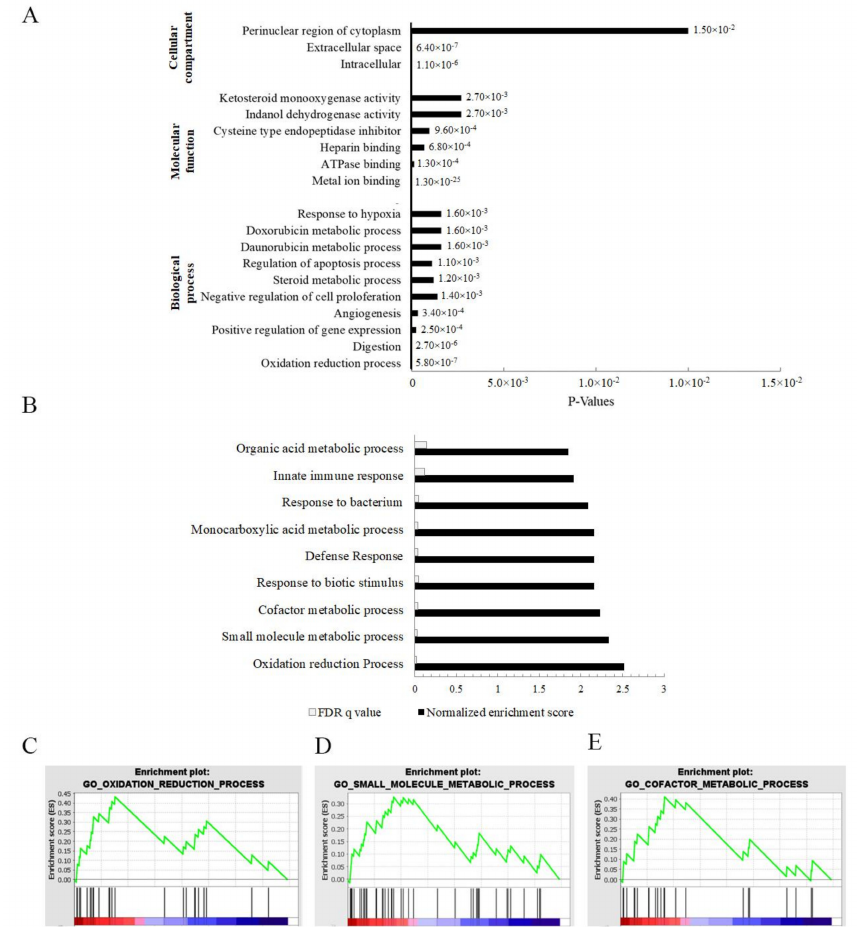
Figure 3. Identification of cisplatin-resistance-related genes in signet ring gastric cancer by bioinfor- matics analysis of RNA sequencing data: ( A ) David Bioinformatics functional annotation according to gene ontology (GO) in biological process, molecular function, and cellular compartment; ( B ) top 10 GO terms of Gene Set Enrichment Analysis; ( C ) oxidation reduction GO term of Gene Set Enrich- ment Analysis; ( D ) small molecule metabolic process GO term of Gene Set Enrichment Analysis; ( E ) cofactor metabolic process GO term of Gene Set Enrichment